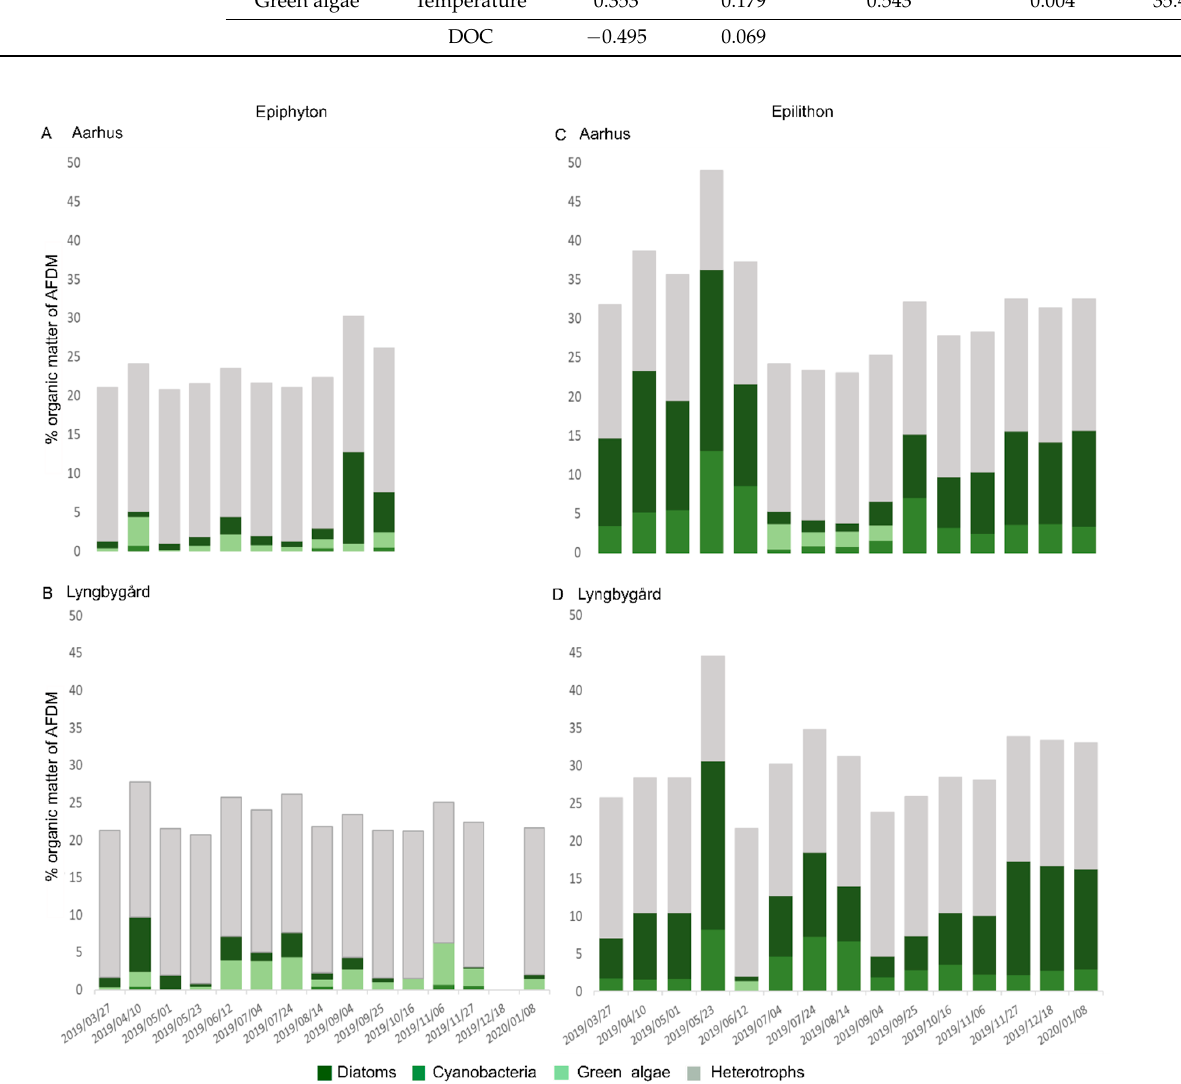
Figure 3. Changes of biofilm composition over the year. ( A ): epiphyton at Aarhus stream; ( B ): epiphyton at Lyngbygård stream; ( C ): epilithon at Aarhus stream and ( D ): epilithon at Lyngbygård stream. Epiphyton only present at samplings date where macrophytes are present.